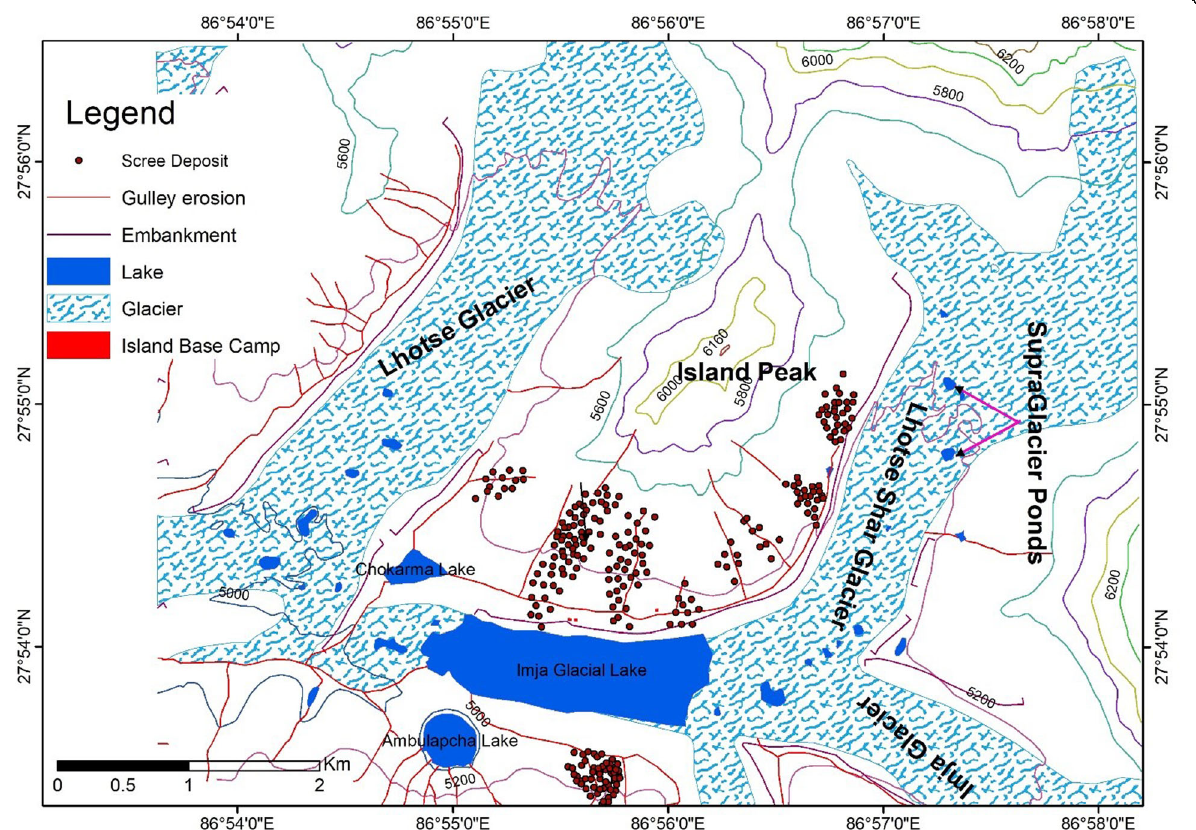
Fig. 3 Engineering geological map of the study area